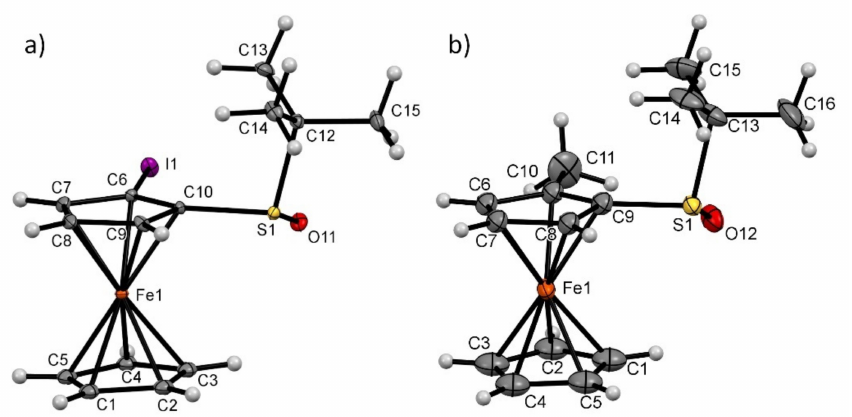
Figure 4. Molecular structure of the compounds ( a ) S , R P -1b and ( b ) S , S P -1d at the solid state. Thermal ellipsoids shown at the 30% probability level. Selected bond lengths [Å] and angles [ ◦ ] for S , R P -1b : C10-S1 = 1.791(4), C6-I1 = 2.099(4), O11-S1-C10-C6 = − 15.57. Selected bond lengths [Å] and angles [ ◦ ] for S , S P -1d : C9-S1 = 1.766(7); C10-C11 = 1.500(1), O12-S1-C9-C10 = −